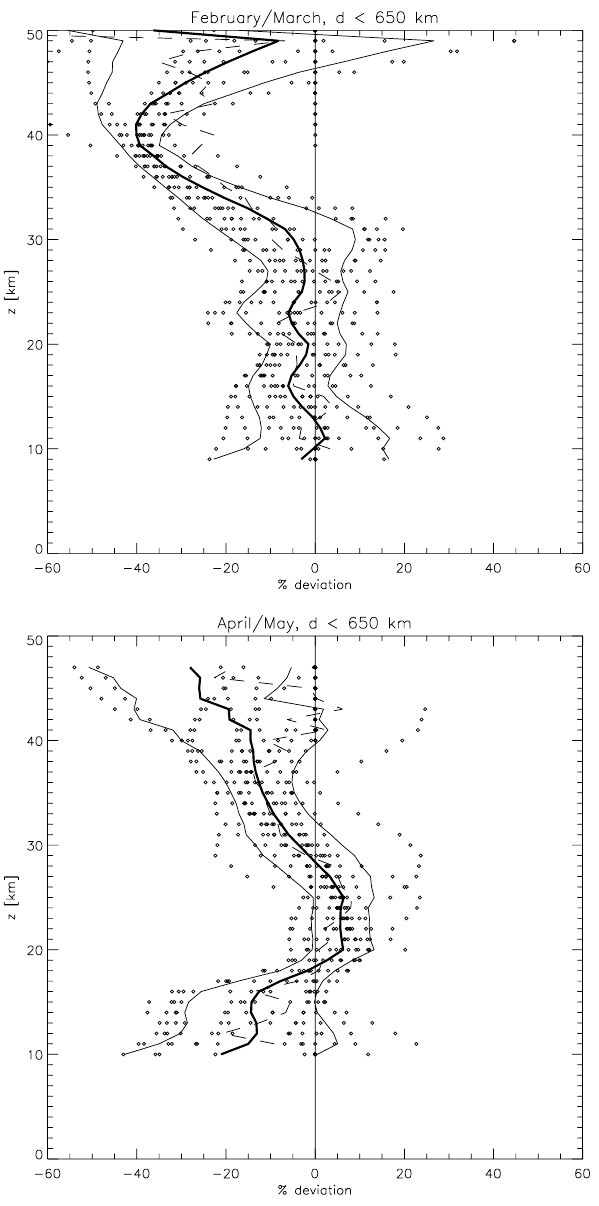
Fig. 6. As Fig. 3 with 650km radius, but only for the months of February/March (upper panel) and April/May (lower